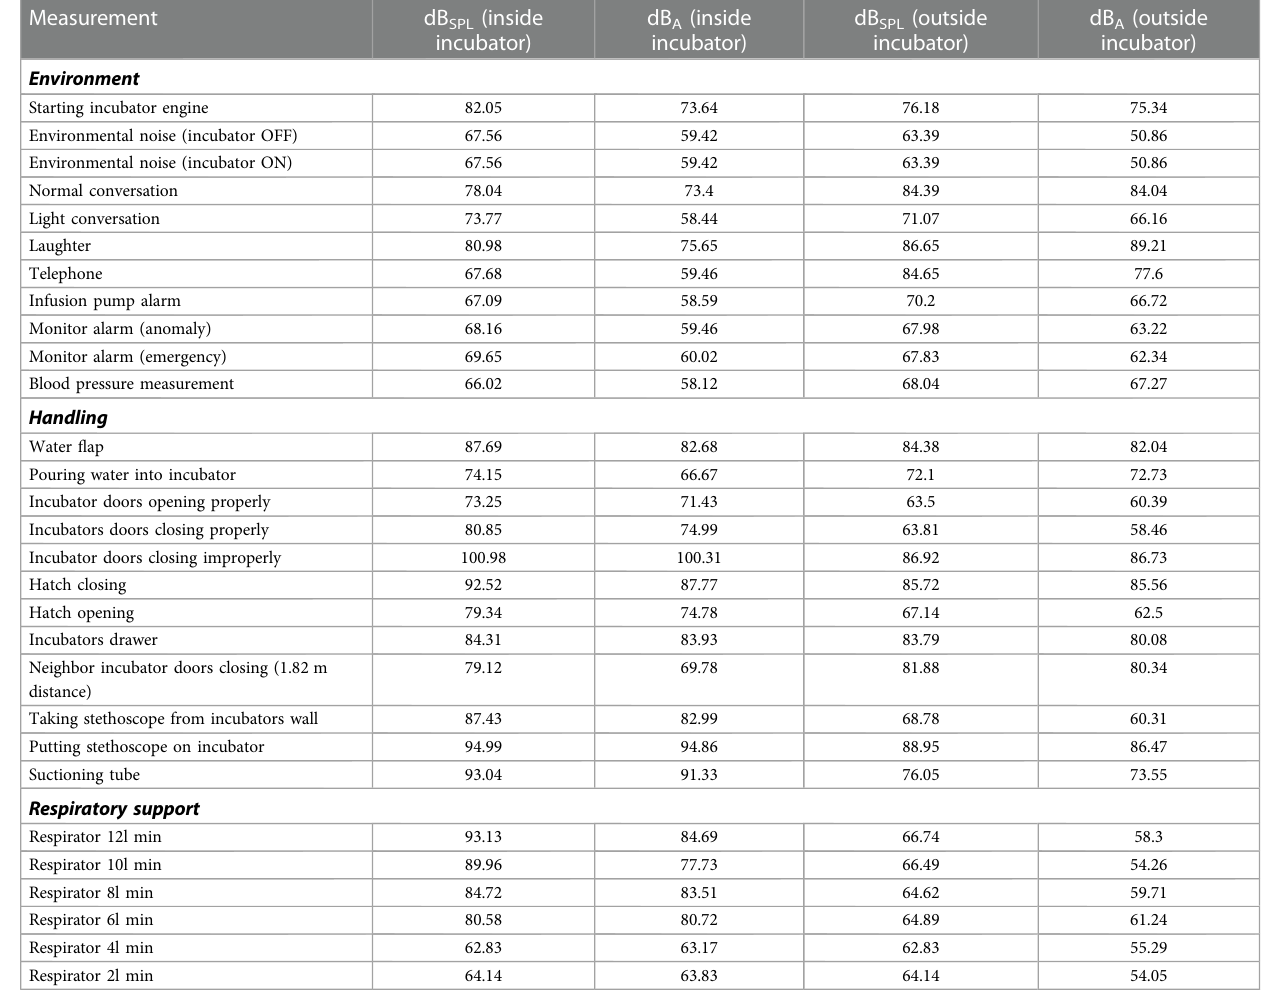
TABLE 1 Measured noise values in dB SPL and dB A within the simulation room and